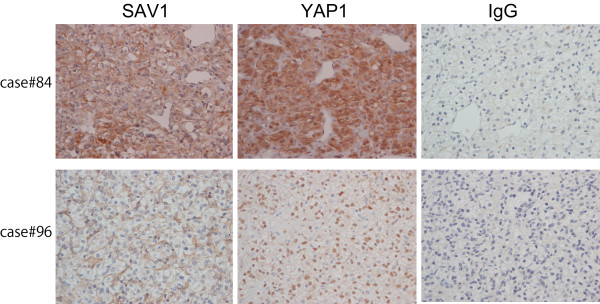
Nuclear localization of YAP1 is frequently detectable in ccRCCs with SAV1 downregulation. Immunohistochemistry of ccRCC tissues using anti-SAV1 antibody and anti-YAP1 antibody (×400). Representative results are shown. YAP1 tends to be localized in the nucleus of tumor cells in cases showing downregulation of SAV1 (case #96), whereas it tends to be localized mainly in the cytoplasm of tumor cells without downregulation of SAV1 (case #84). The cytoplasm of endothelial cells is positively immunostained. No positive staining is detectable in both cases using normal mouse IgG as the primary antibody (IgG).